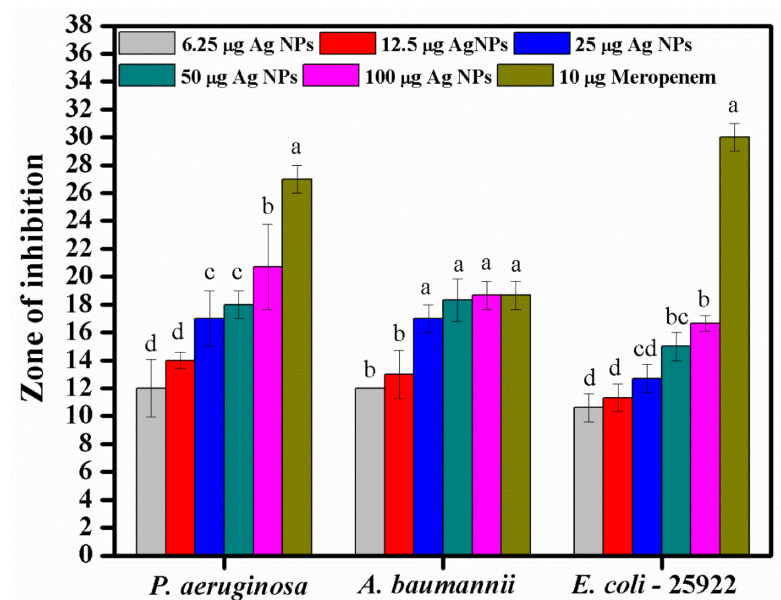
Figure 7. Antibacterial activities of the synthesized Ag NPs and the standard antibiotic Meropeneom (10 µ g) against ventilator-associated pneumoniae causing multidrug-resistant gram-negative clinical pathogens with the reference strain ATCC E. coli -25922. The T-bars represent standard errors. The di ff erent small alphabet letters above each column indicate significant di ff erences (ANOVA, Tukey’s HSD test, p ≤